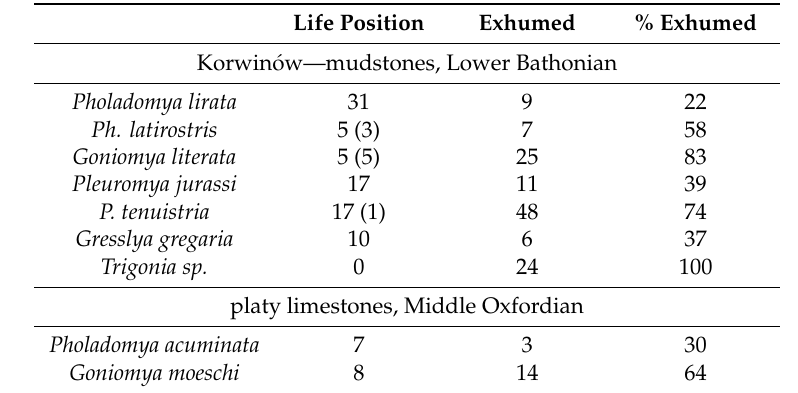
Figure 5. Compaction of fossil in sediment. Factors affecting the difference in the degree of shortening of the shell and the channel left by the siphon. Table 1. Frequency of exhumed specimens of burrowing species in two specific lithologies (described in the text). The number in parentheses indicate the number of specimens preserved with dorsal edge horizontal. Platy limestones are from Rz ę dkowice (22 specimens) and several other exposures with the same lithology.